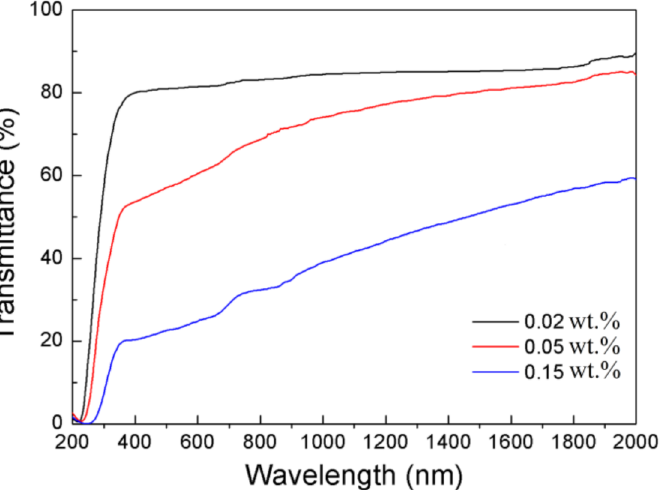
Figure 5. In-line transmission of the Y 2 O 3 ceramics with different CaO contents vacuum sintered at 1550 ◦ C and HIP-ed at 1510 ◦